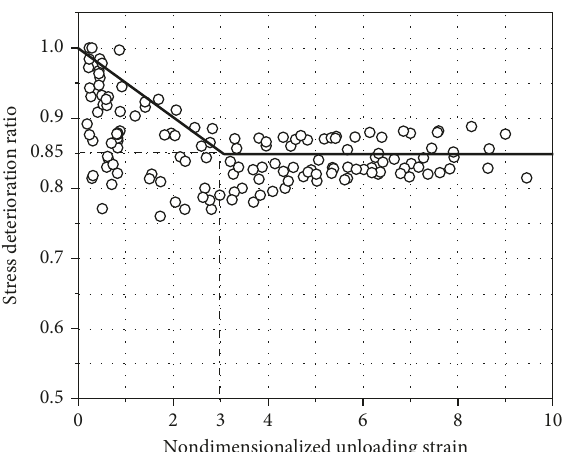
Figure 13: Relation between stress deterioration ratio and nondimensionalized unloading strain for